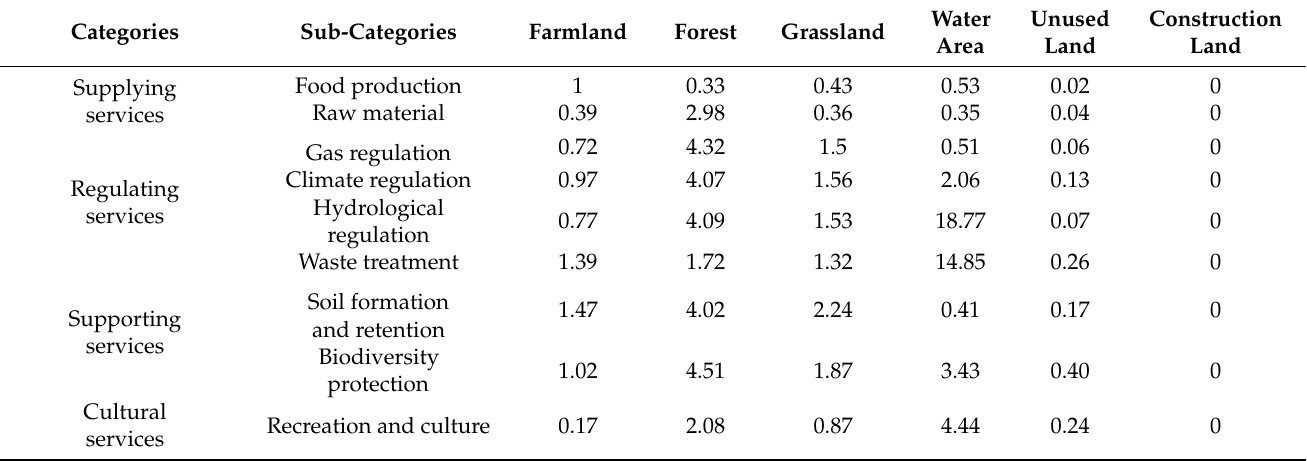
Table 1. Equivalent value per unit area of ecosystem services in China.